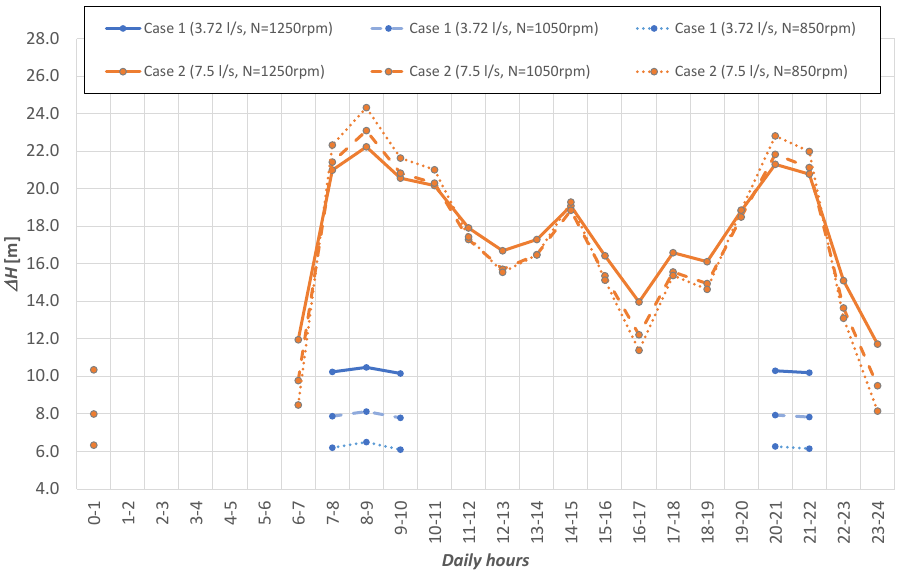
Figure 12. Daily distribution of head drop for the investigated scenarios (blue for µ q = 3.72 L/s and orange for µ q = 7.50 L/s) and PAT speed (solid for N = 1250 rpm, dashed for N = 1050 rpm, and dotted for N = 850